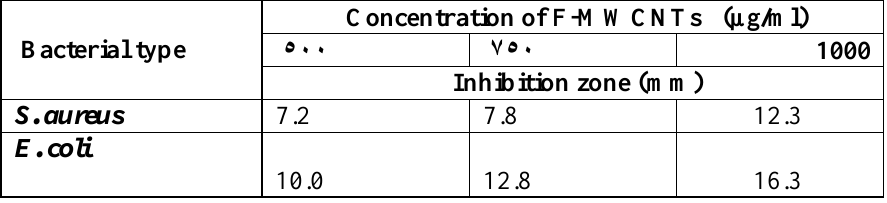
Figure 6: Images of Inhibition Zone diameter (IZ) with different concentrations of antibacterial F-MWCNTs against S. aureus and E. coli . Table 2: Inhibition Zone diameter (IZ) with different concentrations of antibacterial F-MWCNTs against S. aureus and E. coli